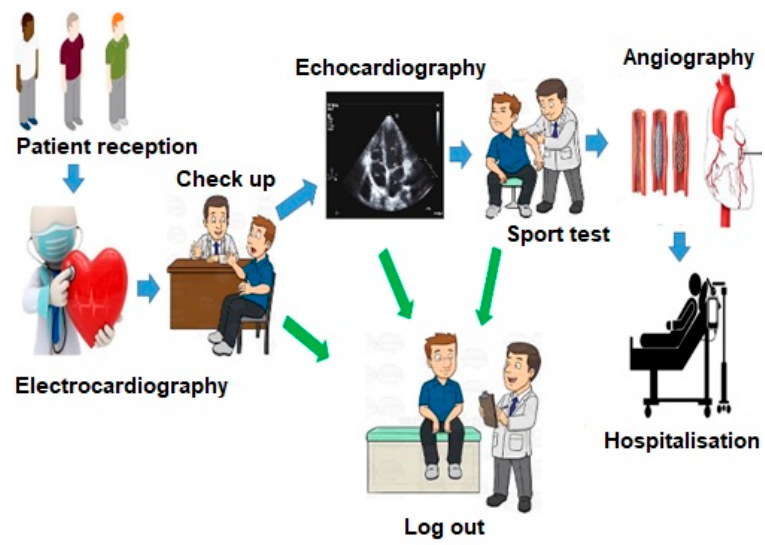
Figure 4. A simple schematic of patient workflow in a heart clinic.